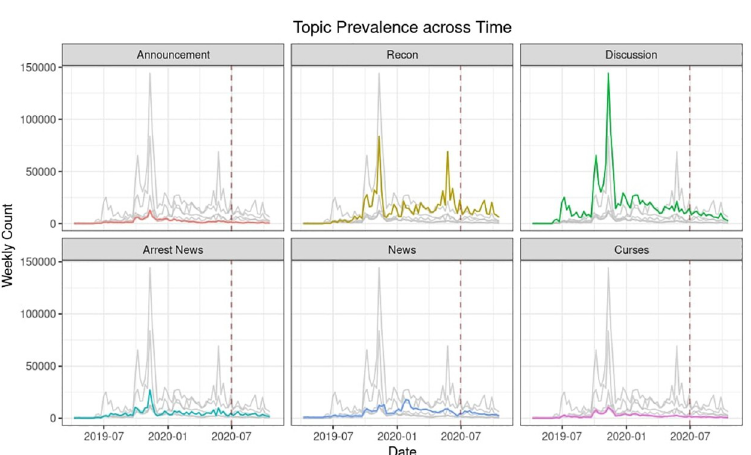
Fig 7. Topic prevalence across time. Red line corresponds to the introduction of the National Security Law.